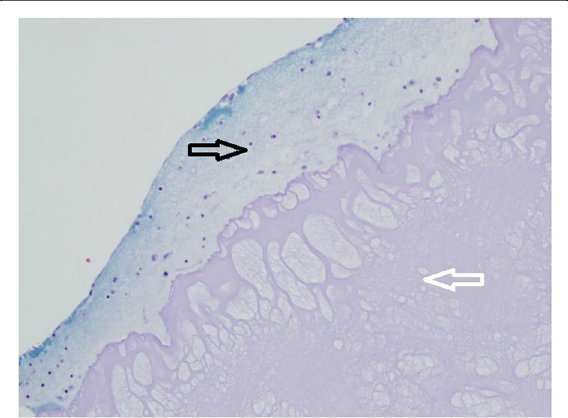
Fig. 3 New cartilage formation in the upper part of the photo Fig. 2 Minced cartilage bone chips fibrin, no digestion with + + detected with Gomori staining and visualized in blue (marked with collagenase (Well 4): Positive staining with S‑100 for chondrocytes black arrow, well 8). The cell elements situated within the newly situated in the lacunas, no chondrocytes seen outside the cartilage formed cartilage matrix. Chitosan based scaffold served as a matrix in pieces (marked with black arrow). Cell elements with extracellular the lower compartment stained in pink (marked with white arrow). matrix beneath the cartilage piece positioned centrally in the figure. These cells weren`t stained with S‑100 and supposedly originate from the bone chips, i.e. bone‑marrow derived cells (marked with white arrow). In the upper corner porcine epidermis with no cell elements (marked with red arrow) can be seen. No adhesion of the newly formed matrix with the piece of cartilage